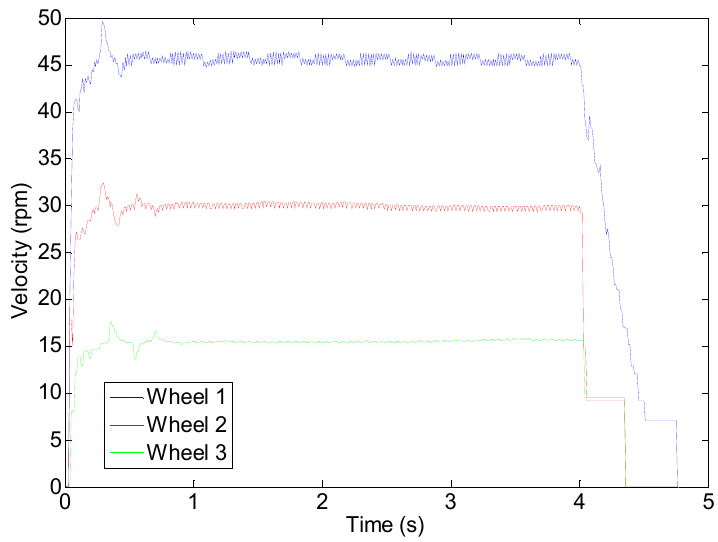
Figure 18. Wheel velocity profile during an open loop operation.